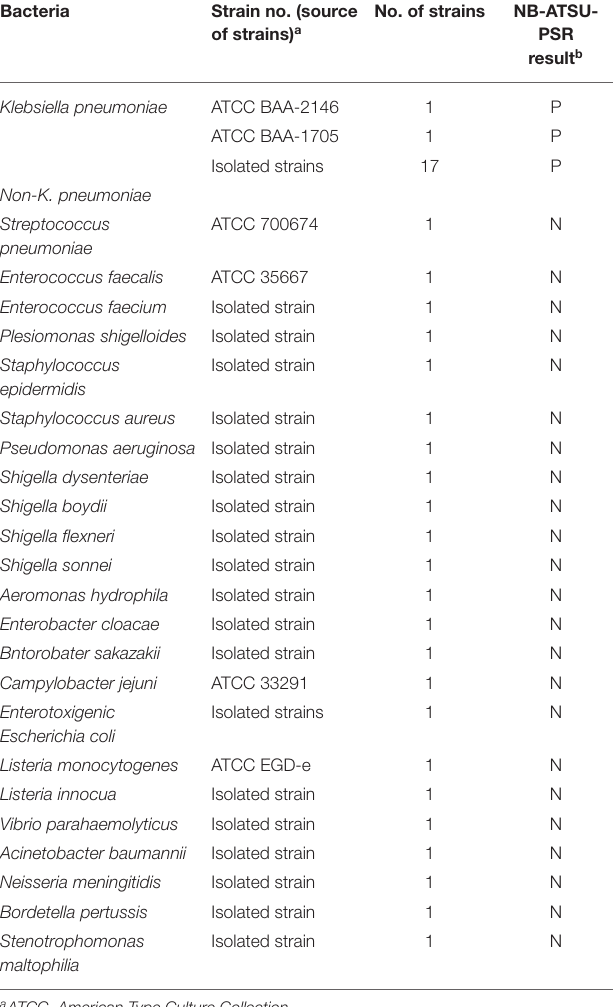
TABLE 1 | Bacterial strains used in this study. Bacteria Strain no. (source No. of strains NB-ATSU- of strains) a